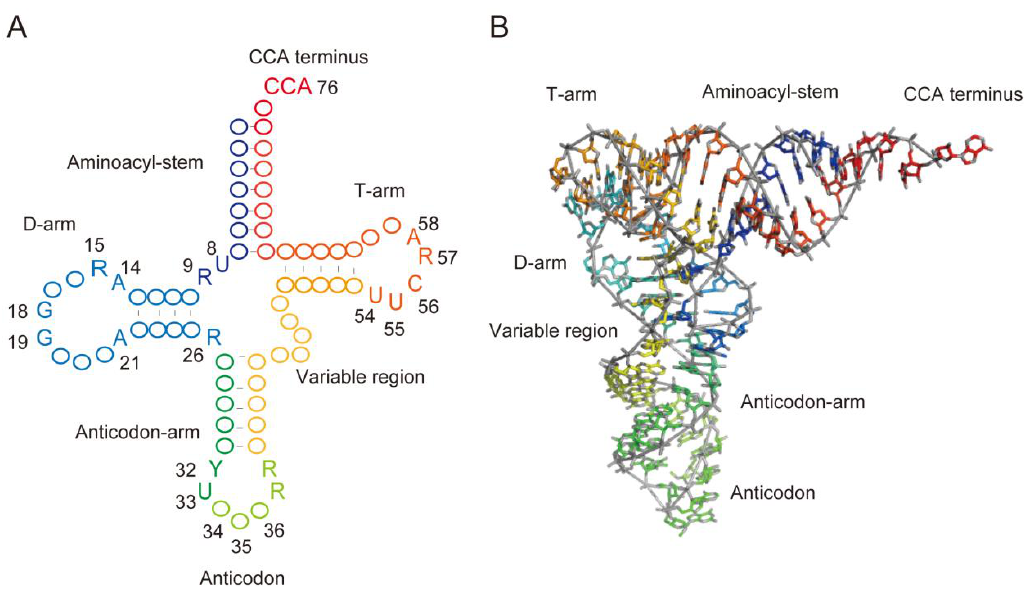
Figure 1. The structure of tRNA. ( A ) Representation of secondary structure of tRNA in a cloverleaf structure. This figure shows tRNA with a short variable region. Conserved nucleosides are shown with position numbers. Abbreviations: R, purine. Y, pyrimidine. ( B ) The L-shaped structure of Saccharomyces cerevisiae tRNA Phe . The colors of nucleosides correspond to those in ( A ).